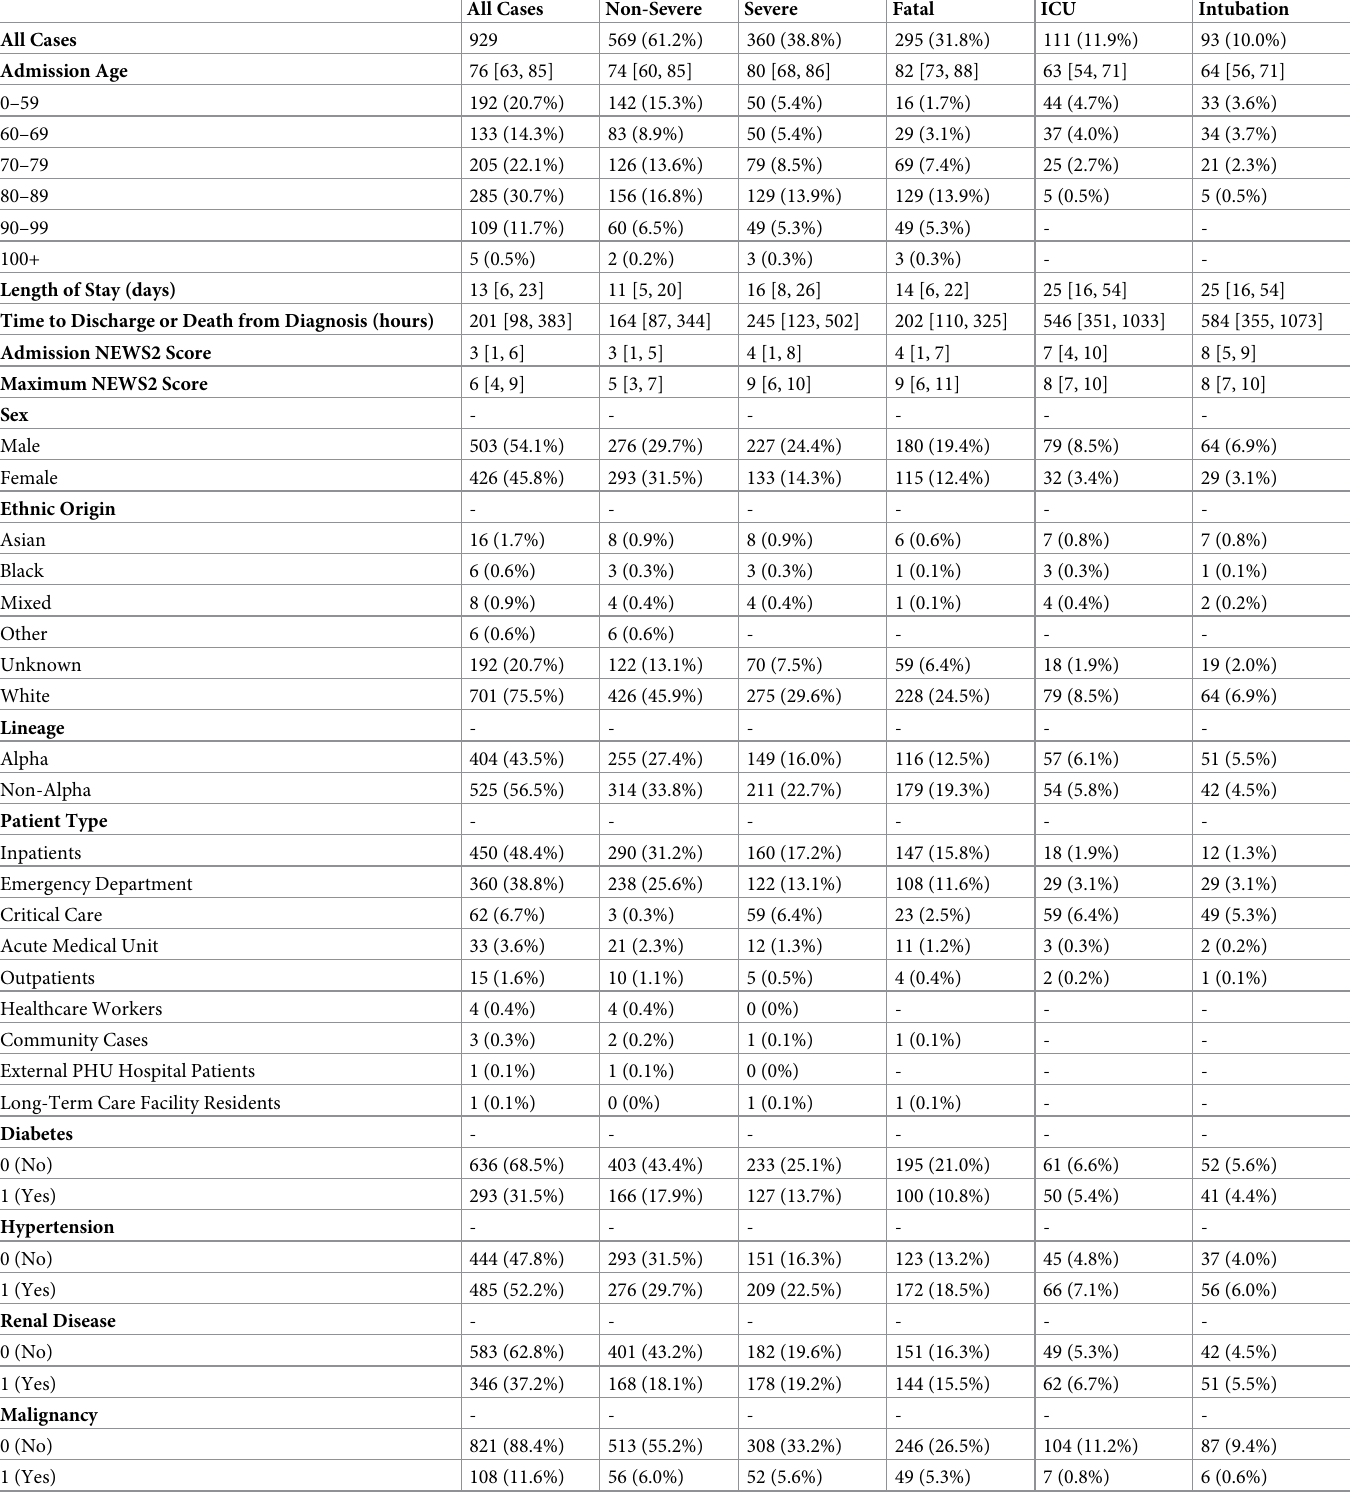
Table 1. Patient data